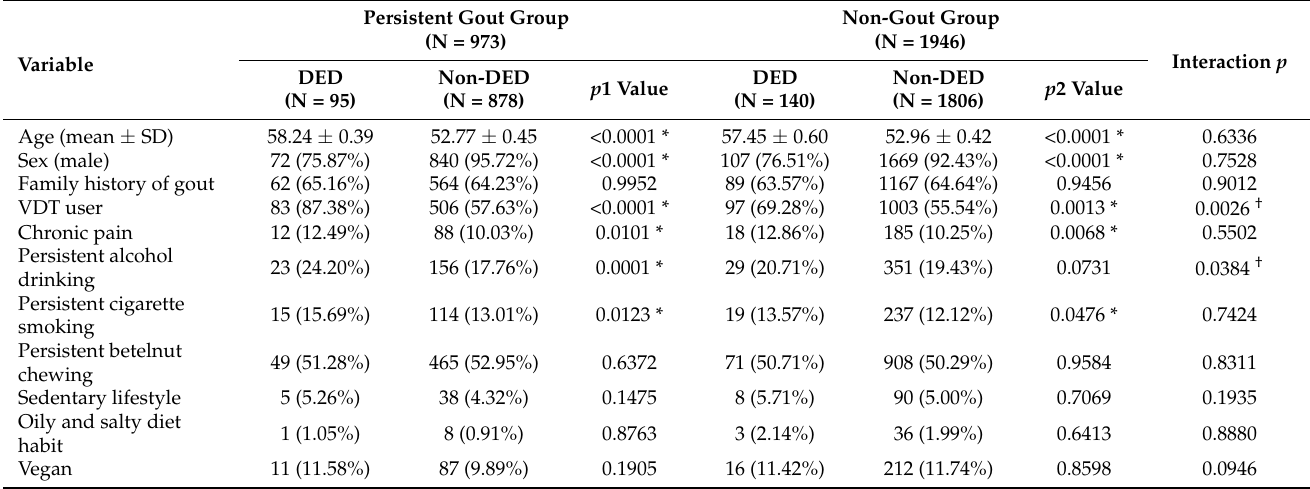
Table 3. The lifestyle and symptom factor and dry eye presence in the persistent-gout and non-gout populations.